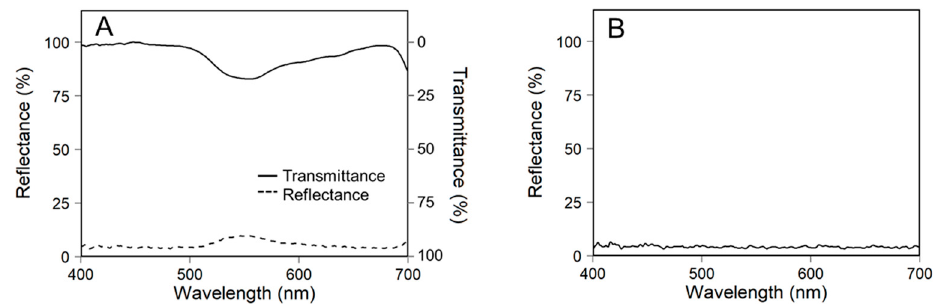
Figure 2. Transmittance and reflectance of a lettuce leaf ( A ) and reflectance of the chamber surface ( B